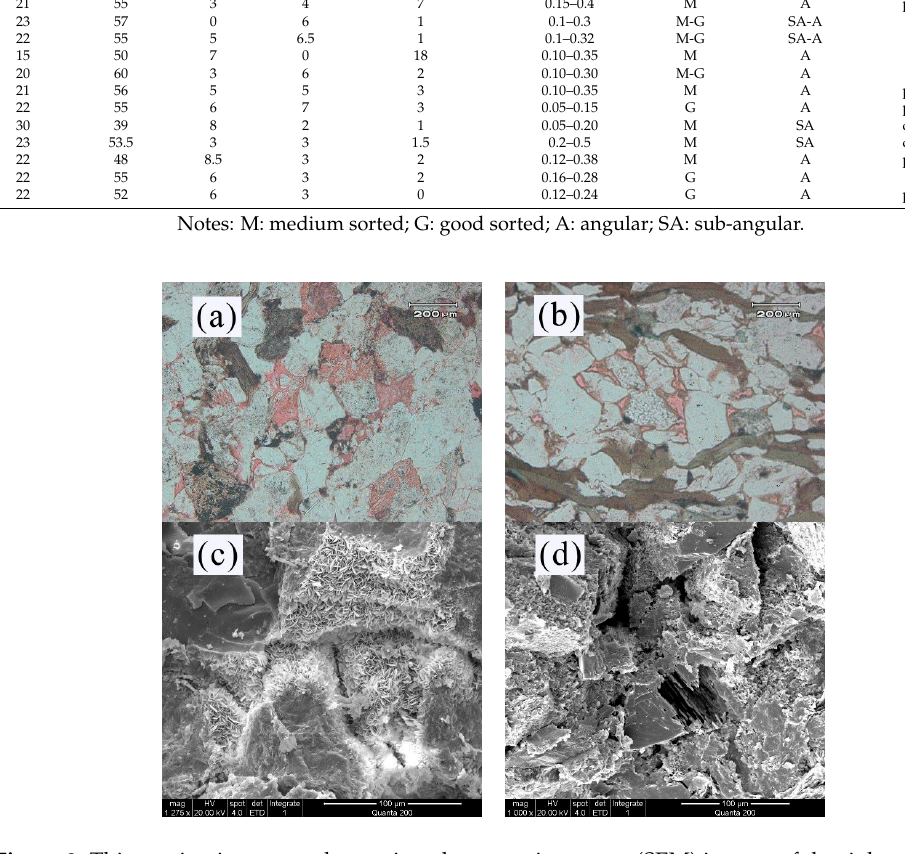
Figure 3. Thin section images and scanning electron microscopy (SEM) images of the tight sandstone in the study area: ( a ) intergranular pores and feldspar dissolution pore; ( b ) intergranular pores and enriched mica; ( c ) the surface of the rock particles covered with padded chlorite; ( d ) feldspar dissolved pore.